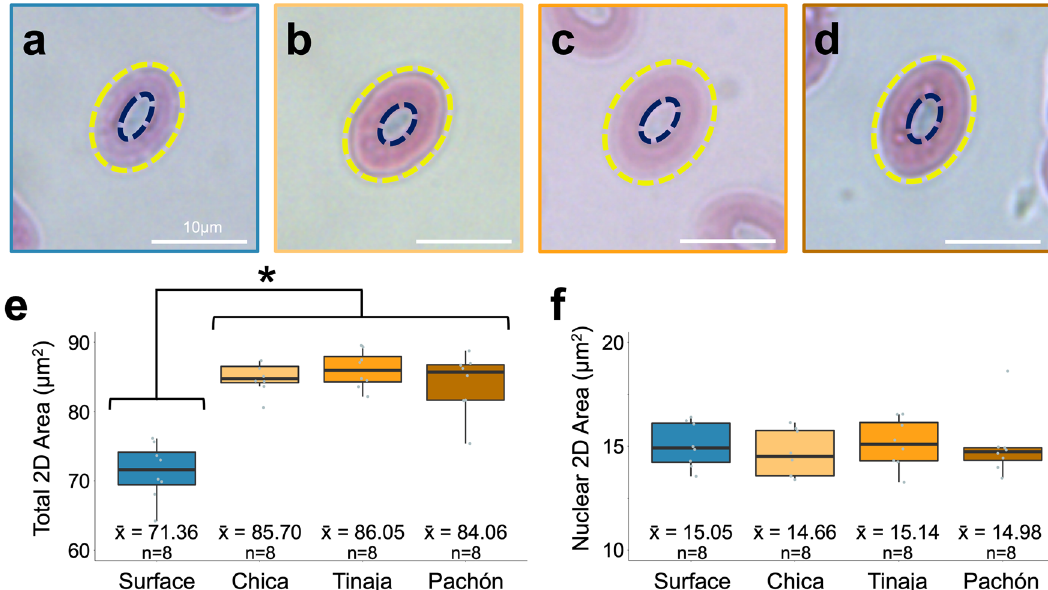
Figure 4. Two-dimensional surface area of cave erythrocytes is significantly larger than surface erythrocytes. Erythrocytes from each population were stained with Wright–Giemsa and visualized under light microscopy ( a – d , scale bar 10 µm). The total ( a – d , yellow ring) and nuclear ( a – d , dark blue ring) two-dimensional area was calculated for each erythrocyte in ImageJ 29 (v2.0.0). The total surface area was significantly higher in all cave populations compared to surface (p < 0.00003) but did not differ from each other ( e ). Although the total two-dimensional area was higher in cavefish, there were no differences in the two-dimensional area of the nuclei ( f ), suggesting the differences in total two-dimensional area are due to differences in the cytoplasm, where hemoglobin is found. Two outliers were detected (the highest Chica value and the lowest Pachón value). Removal of these outliers did not change statistical significance (Table S6).